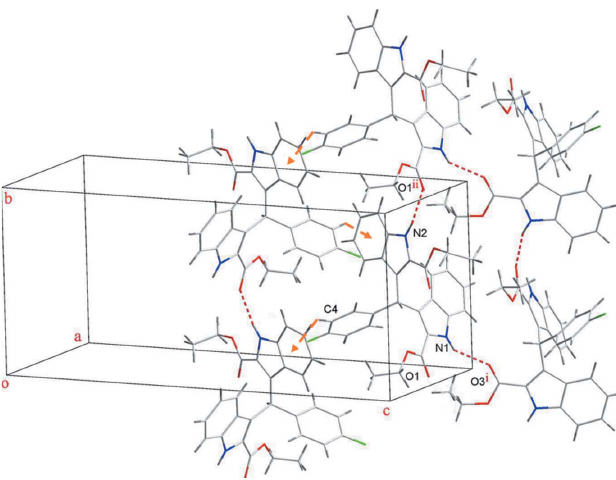
Figure 2 A view along the a axis of the crystal packing of the title compound.